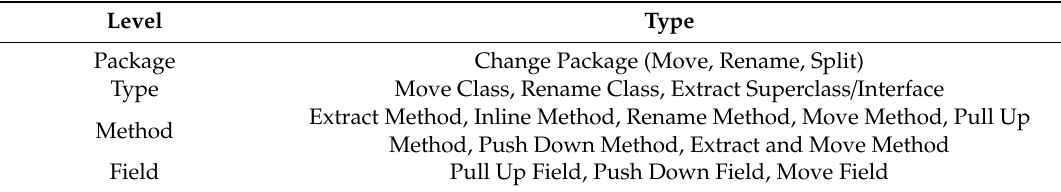
Table 4. Refactorings detected by Refactoring